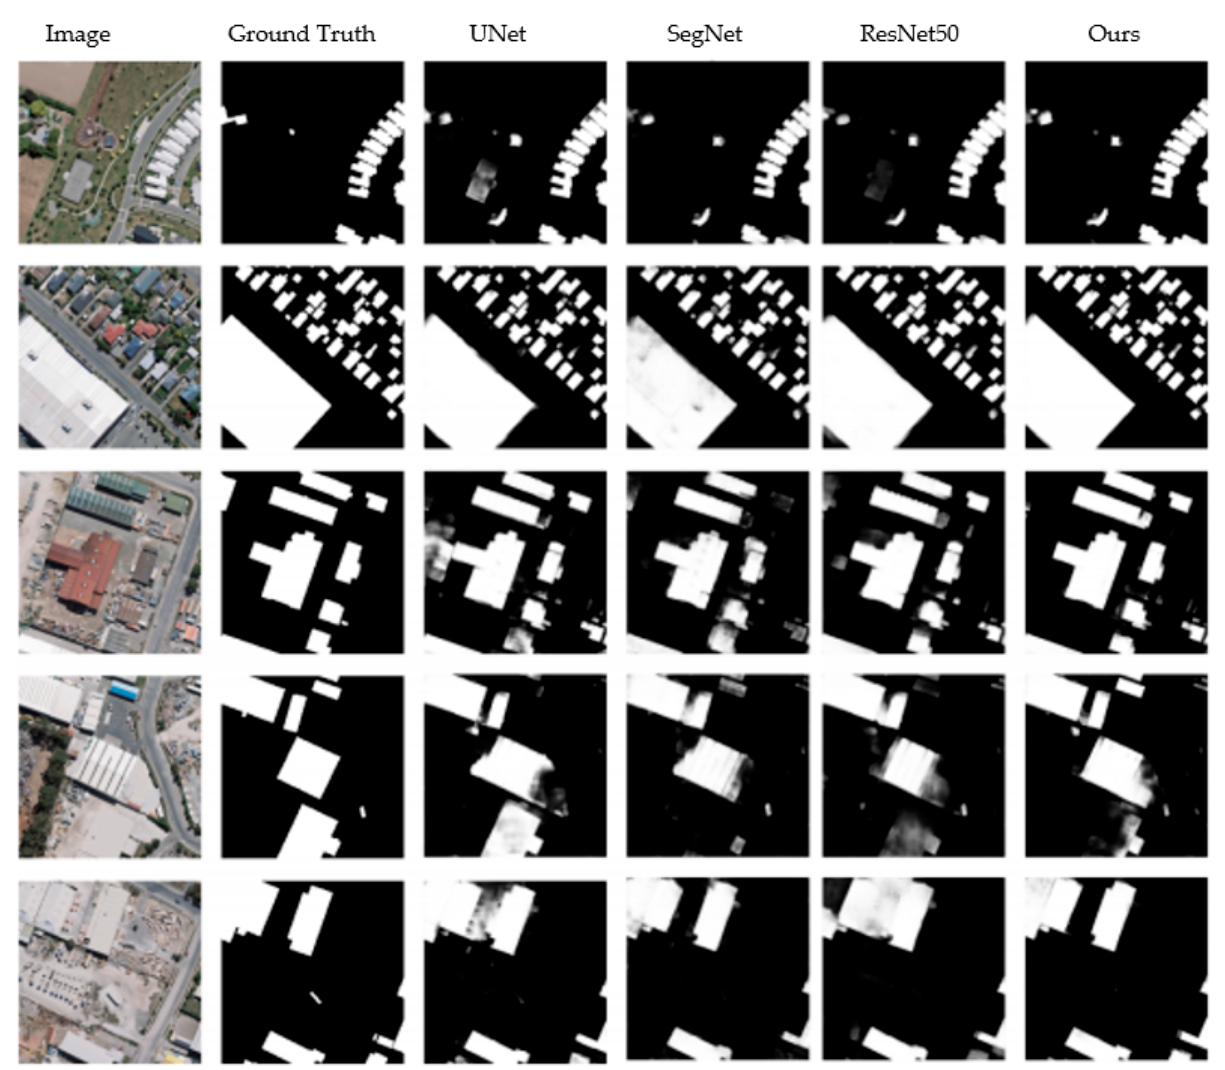
Figure 7. Some representative results of comparisons on the benchmark.